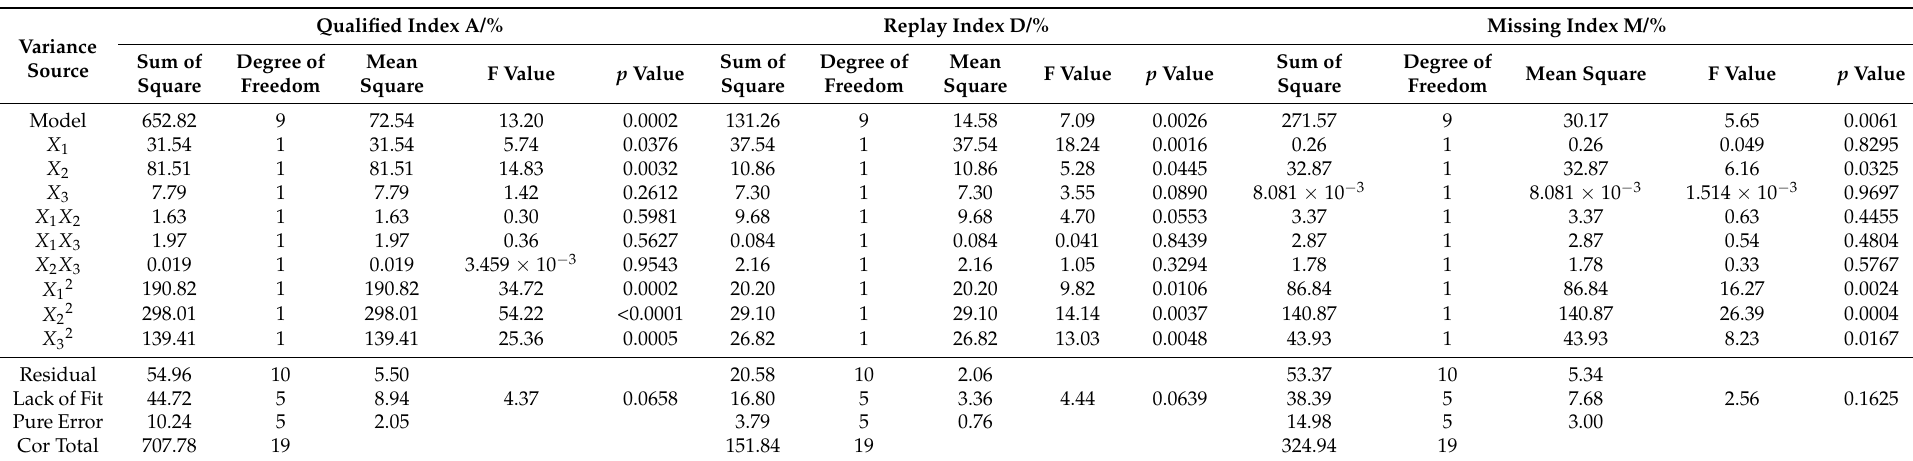
Table 3. Analysis of